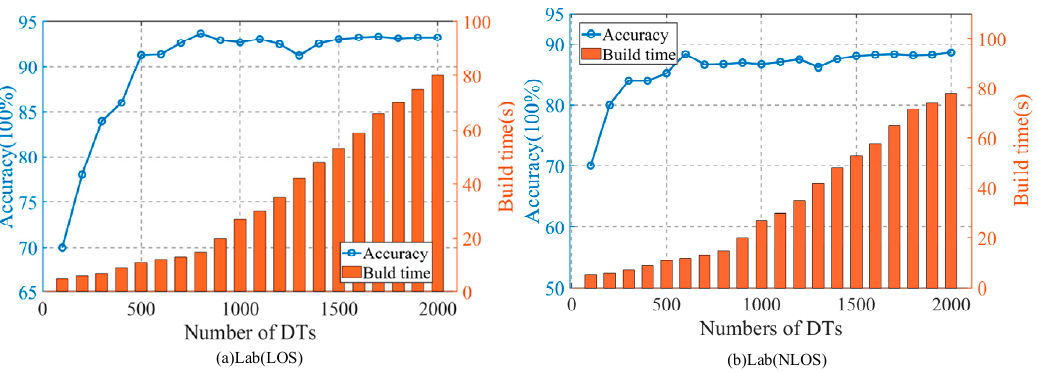
Figure 8. The impact of the size of the random forest on the accuracy of the method and construction time. ( a ) Lab (LOS), ( b ) Lab (NLOS).